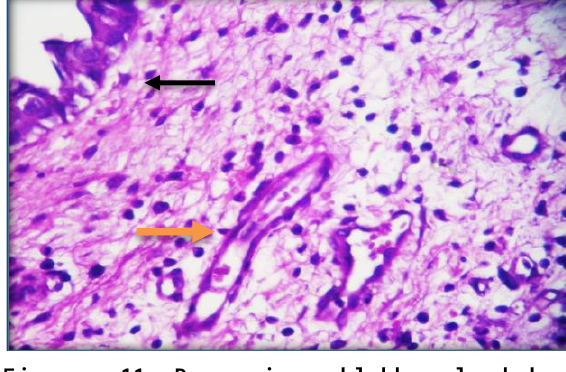
Figure, 11: Dog urinary bladder closed by appositional pattern, 7 days post-operation shows, granulation tissue (orang arrow) in addition to fibrin deposition, neutrophils and mononuclear cells infiltration (black arrow) in sub-epithelial layer (H&E.,